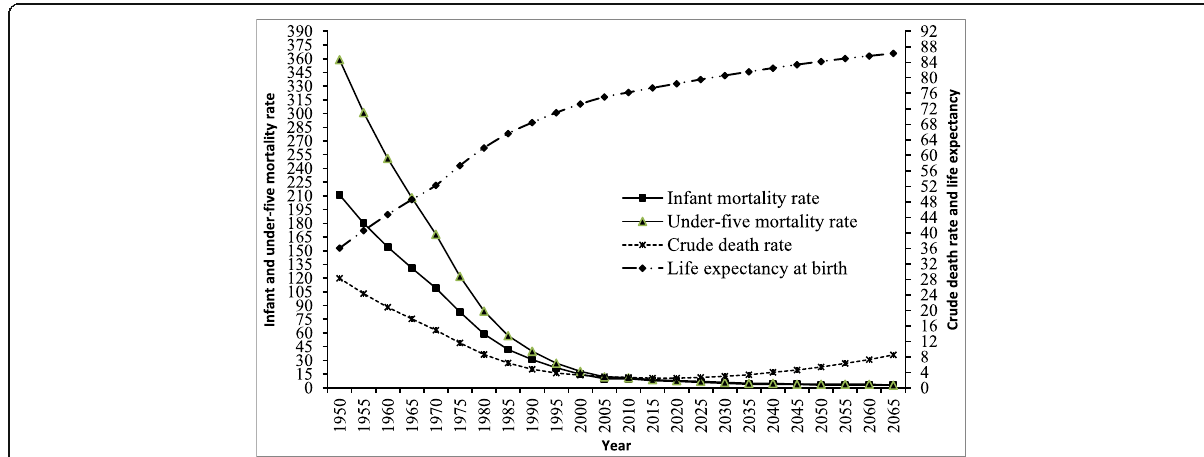
Fig. 2 Infant and under-five mortality rates, crude death rates and life expectancy at birth, Oman 1950 – 2065. Source: UN population estimates and projection [27]